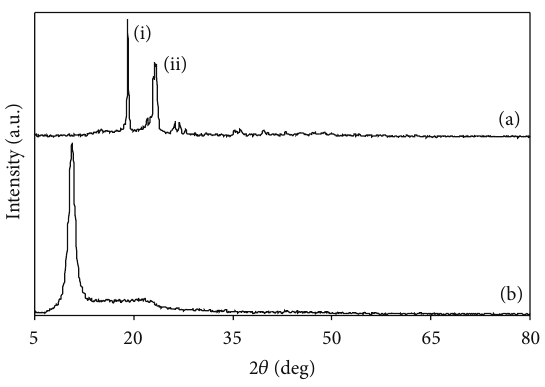
Figure 1: XRD pattern for (a) pure PEO and (b) pure GO.